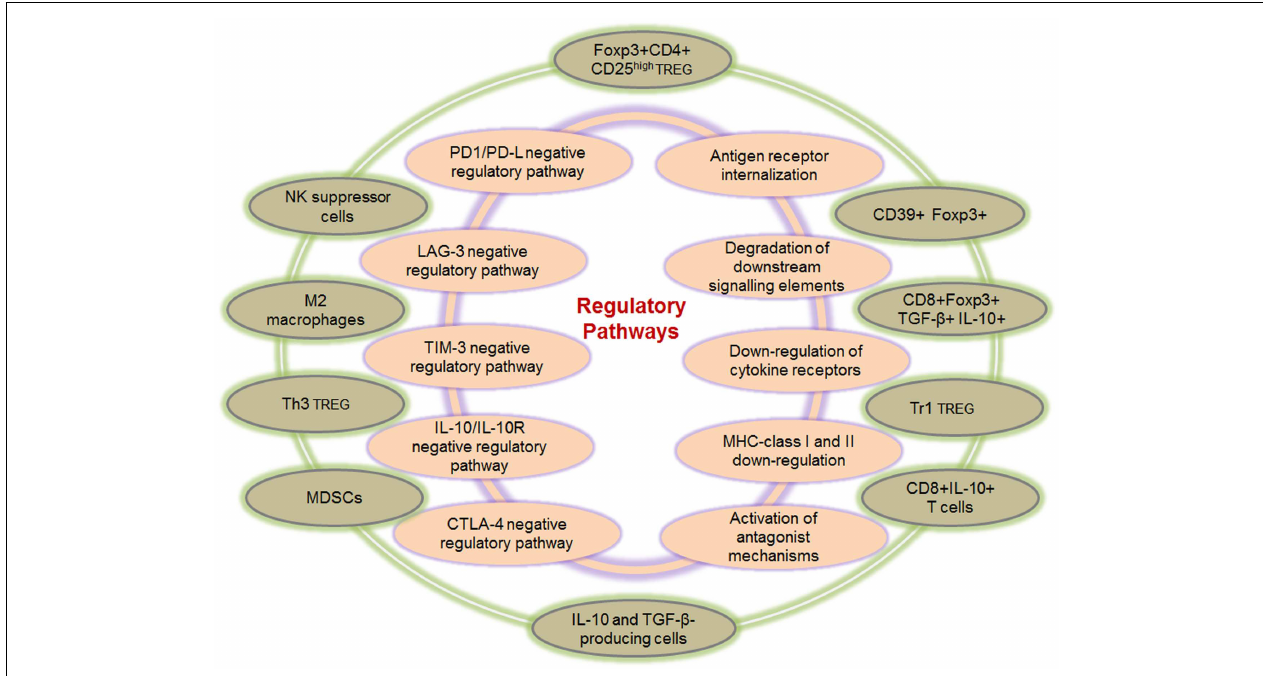
FIGURE 1 | Intrinsic and extrinsic immune-regulatory pathways . Several pathways of immune-regulation exist, and these comprise intrinsic and extrinsic mechanisms. Intrinsic pathways (inner circle) derive from within the effector cell and usually involve up-regulation of inhibitory receptors, down-regulation of cytokine andT cell activation receptors, down-regulation of MHC molecules, as well as the degradation of downstream signaling elements. Although the intrinsic pathways derive mainly from within the effector or antigen presenting cells, interactions with external elements